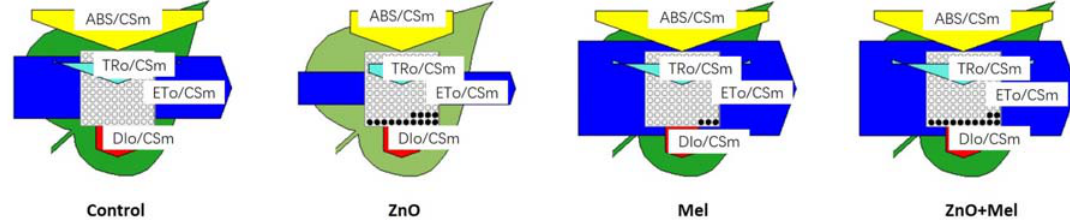
Figure 4. Energy pipeline leaf model of phenomenological fluxes (per cross-section, CS) in the last fully expanded leaf in wheat as affected by melatonin application and Zinc Oxide (ZnO) nanoparticles. Mel, melatonin. Data represent the mean ± SE of three replicates. Each relative value is drawn by the width of the corresponding arrow, standing for a parameter. Empty and full black circles indicate, respectively, the percentage of active (QA reducing) and non-active (non-QA reducing) reaction centres of PS II. TRo/CSm, trapped energy flux per CS; ETo/CSm, electron transport flux per CS; ABS/CSm, absorption flux per CS; DIo/CSm, non-photochemical quenching per CS.